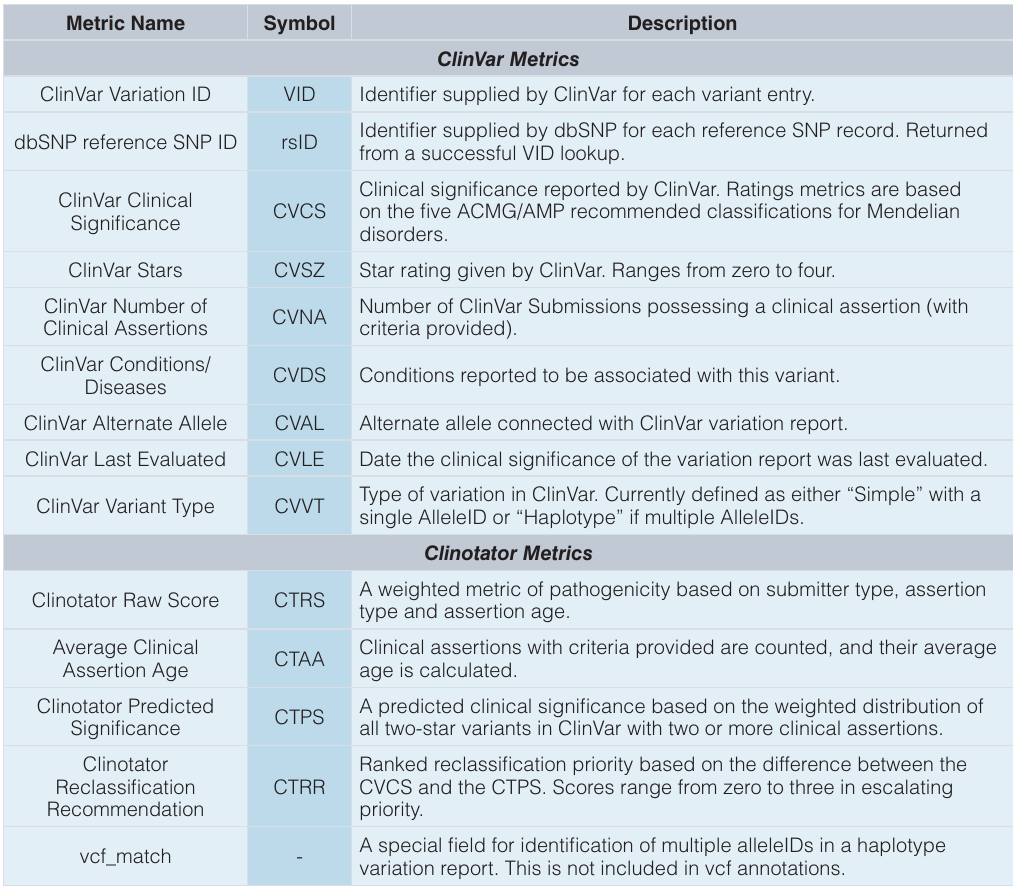
Table 1. Metrics provided by Clinotator